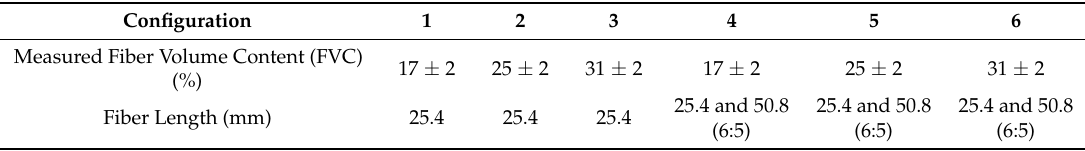
Table 2. Real fiber volume content and fiber length distribution of the six different sheet molding compounds (SMC) materials considered within this